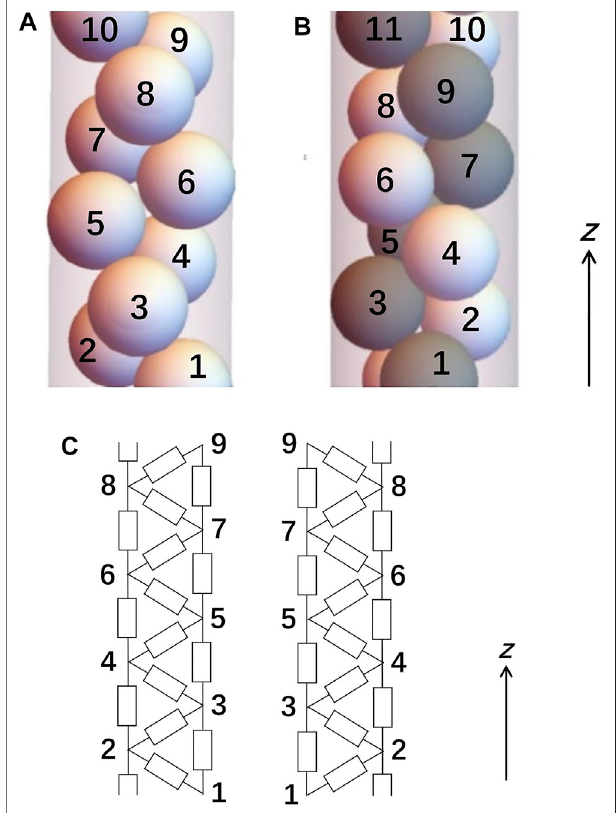
FIGURE 3 | Schematic illustration of (A) a single-helix structure at (cid:1)(cid:1) √ (cid:1)(cid:1) √ D ∈ ( 1 + 3 /2 , 1 + 4 3 /7 ) and (B) a double-helix structure at (cid:1)(cid:1) √ D ∈ ( 1 + 4 3 /7 , 2 ) , as well as (C) the corresponding electrical circuit (i.e. a resistor network not drawn to scale) for either structure. The spheres in each structure are indexed in ascending order of their vertical z -positions. As shown in Panel (C) , this electrical circuit, which corresponds to the presence of triplets of mutually touching spheres across each structure, can be presented in two equivalent versions that are mirror images of each